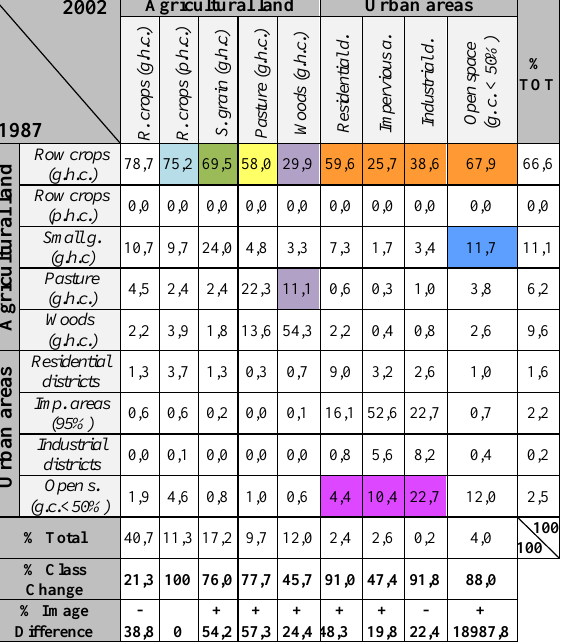
Table 3. Matrices of land cover (LC) and changes (Percentages)